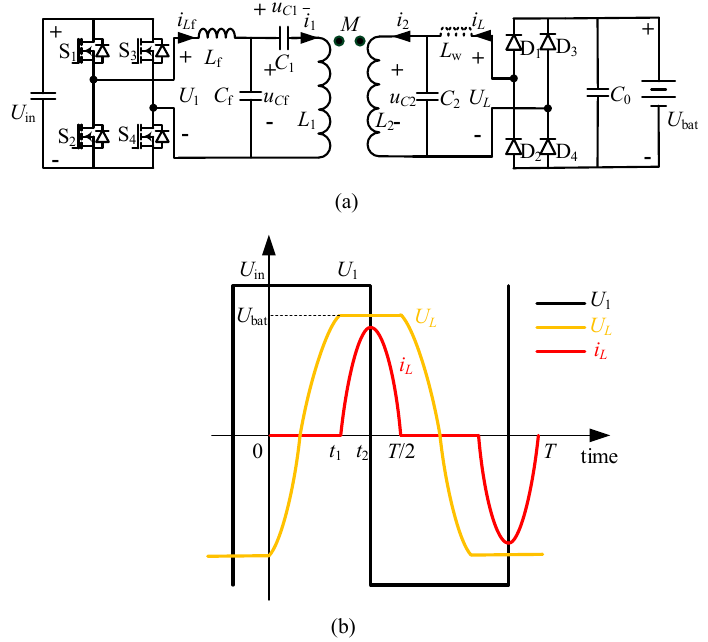
Figure 5. The topology and the waveforms ( a ) Topology without the large filter inductor ( b ) Waveforms of the inverter and the rectifier.